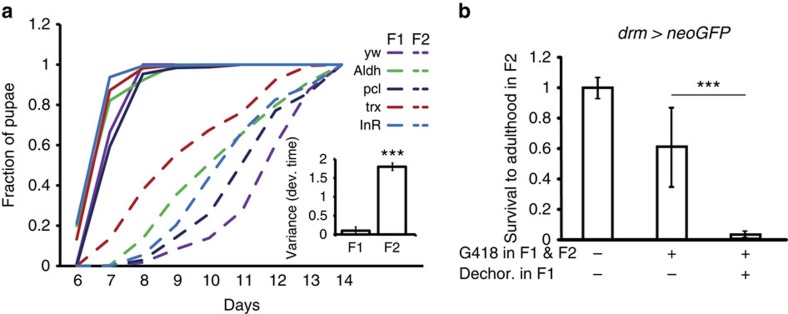
Removal of extracellular gut bacteria exposes 'hidden' mutations and reduces stress tolerance in the next generation.(a) Effect of removal of gut bacteria in F1 on the kinetics of pupation in F1 and F2, shown for wild-type flies (yw) and 4 mutant lines (InR, trx, pcl and Aldh). Inset: statistical analysis of the variance in pupation time due to difference in genotype. Shown are variances in genotype-specific median time to pupation. Mean variance±s.e., n=3. Note the substantially larger variance in F2 versus F1. ***P<0.001 (Student's t-test). (b) Effect of removal of gut bacteria in F1 on the survival of F2 drm>neoGFP flies that were exposed to 400 μg ml−1 of G418 in both generations. Note the strong reduction in the survival of F2 flies when G418 treatment was preceded by egg dechorionation in F1. Mean survival to adulthood relative to untreated control±s.e., n=3, **P<0.01 (Student's t-test).